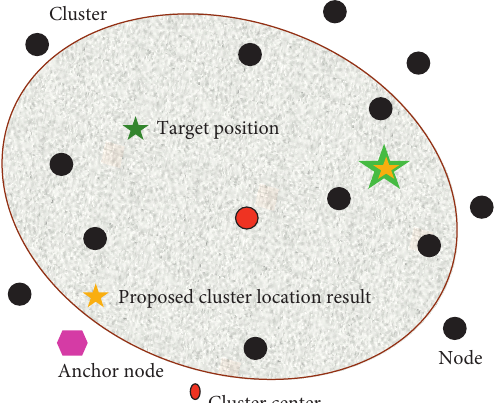
Figure 9: Expected WSN cluster